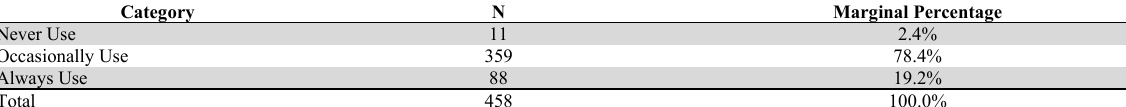
Ordinal Logistic Regression Analysis for Actual use Behaviour Category N